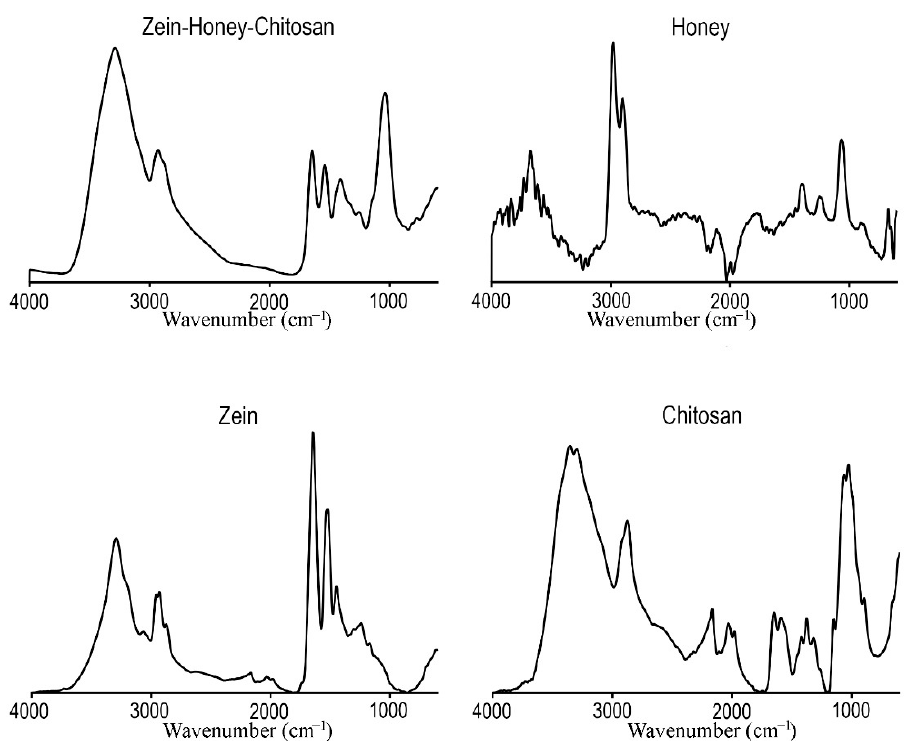
Figure 2. FTIR spectra (transmittance vs. wavenumber) of NPs and individual components used for NPs production.